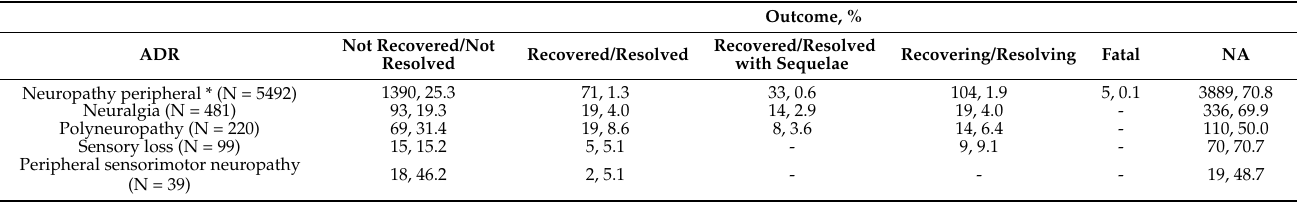
Table 4. Outcome of adverse drug